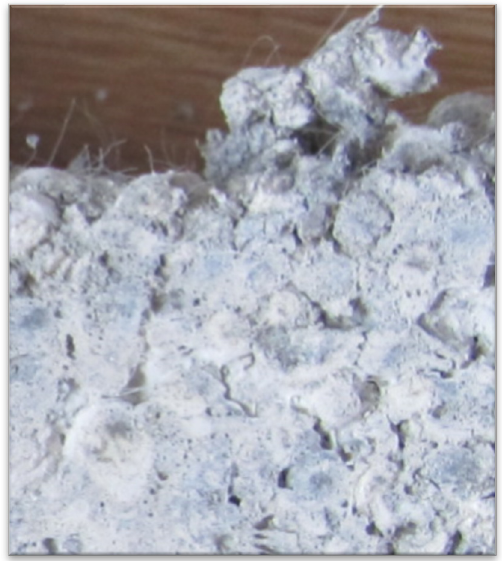
Figure 2. Real view of material structure with visible microfibers improving the resistance to deformation and mechanical damage.